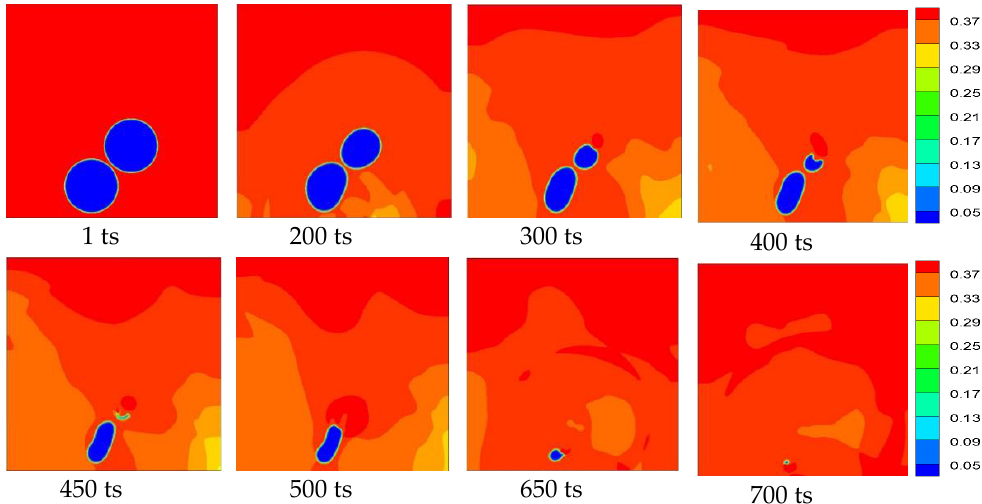
Figure 6. Experimental images: λ = 1.6, 𝑅 0 = 1.45 × 10 −3 𝑚 .